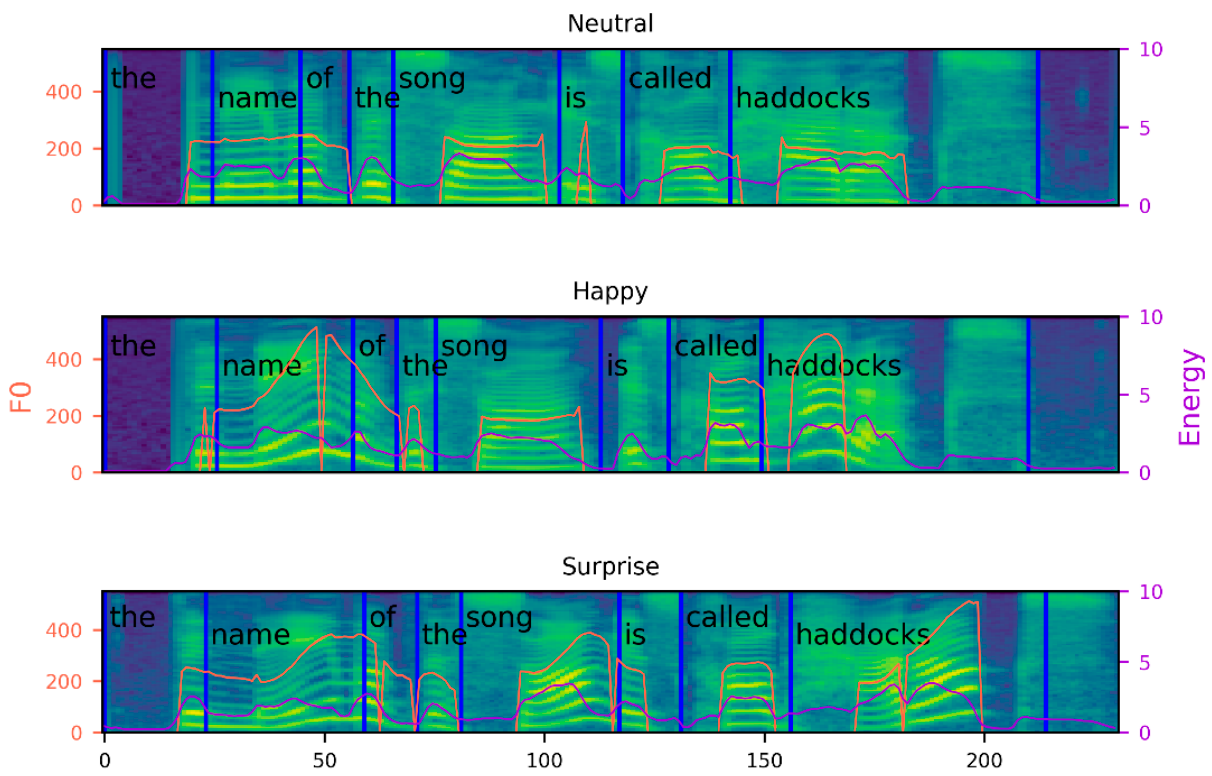
Figure 3. Synthesized speech spectrum referring to different emotional reference speech. Table 5. Emotion recognition